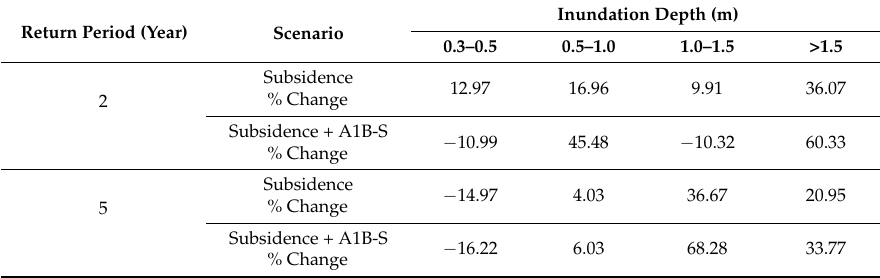
Table 6. Percentage of inundation volume increase for one-day storm under different return periods and